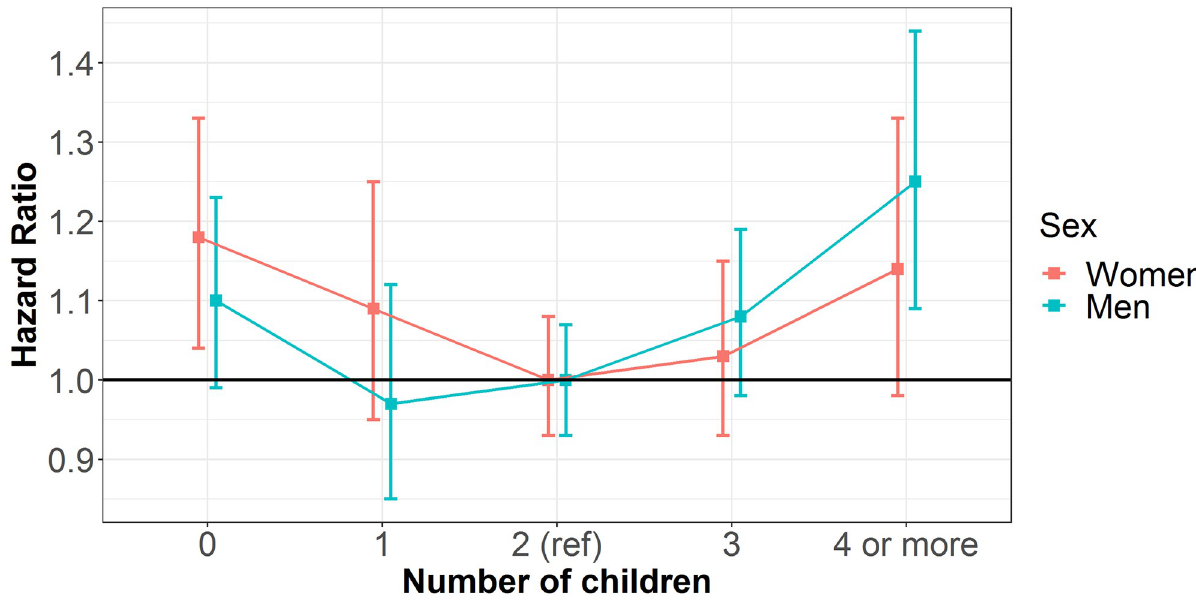
Fig 2. Multiple adjusted HRs for the risk of dementia associated with number of children for women and men. The HRs are plotted on a floating absolute scale. The squares represent the HRs, and the bars represent the 95% CIs. Analyses were adjusted for age, Townsend deprivation index, ethnicity, smoking status, systolic blood pressure, BMI, diabetes, total cholesterol, antihypertensive drugs, and lipid-lowering drugs. BMI, body mass index; CI, confidence interval; HR, hazard ratio.